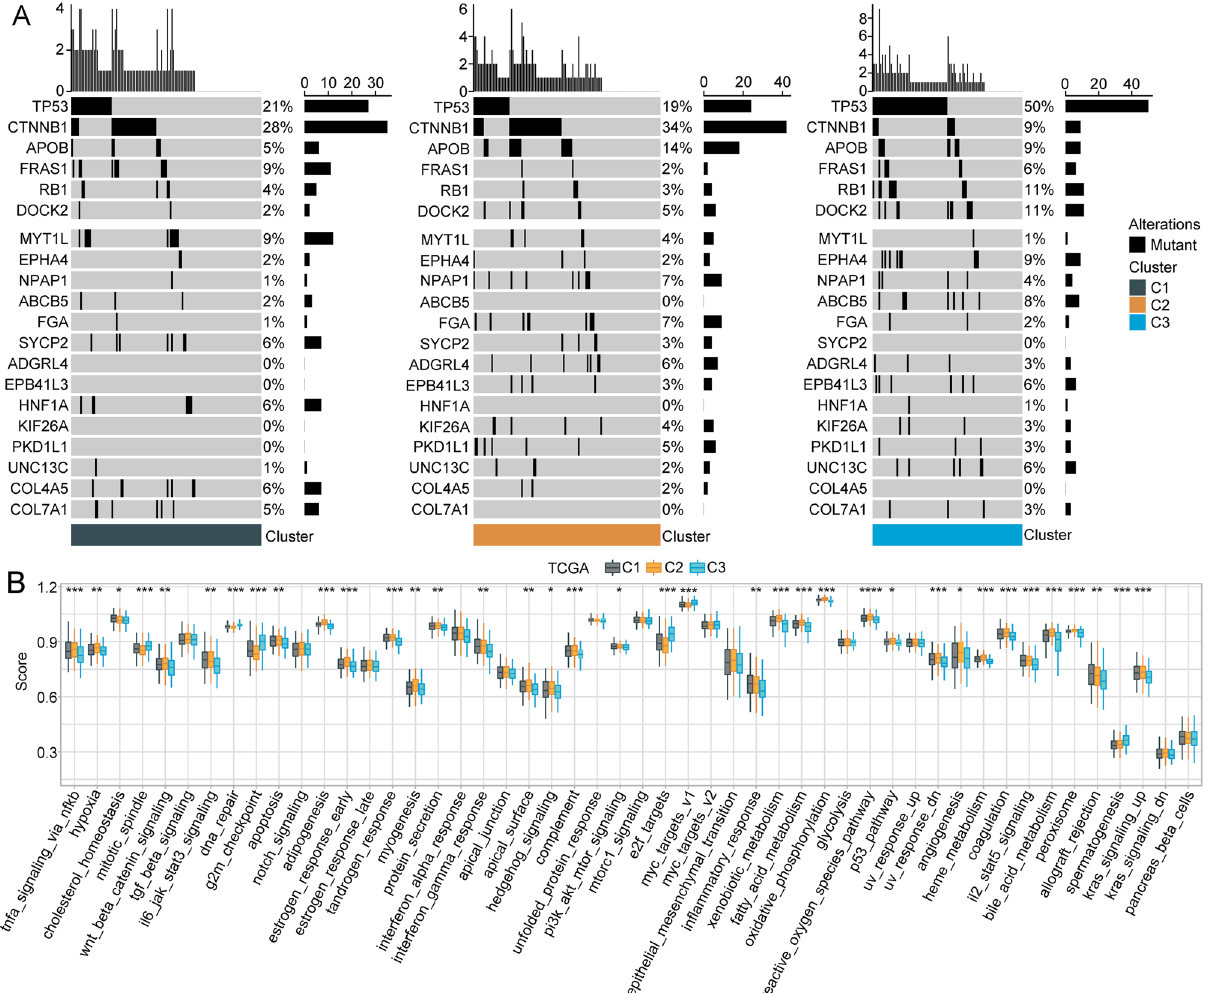
Figure 4. Mutational features of the defined molecular subtypes and differences in the hallmark signaling scores across three subtypes. ( A ) Differential somatic mutation analysis across the three molecular subtypes. ( B ) Boxplots showing tumor-related ssGSEA pathway scores in the TCGA